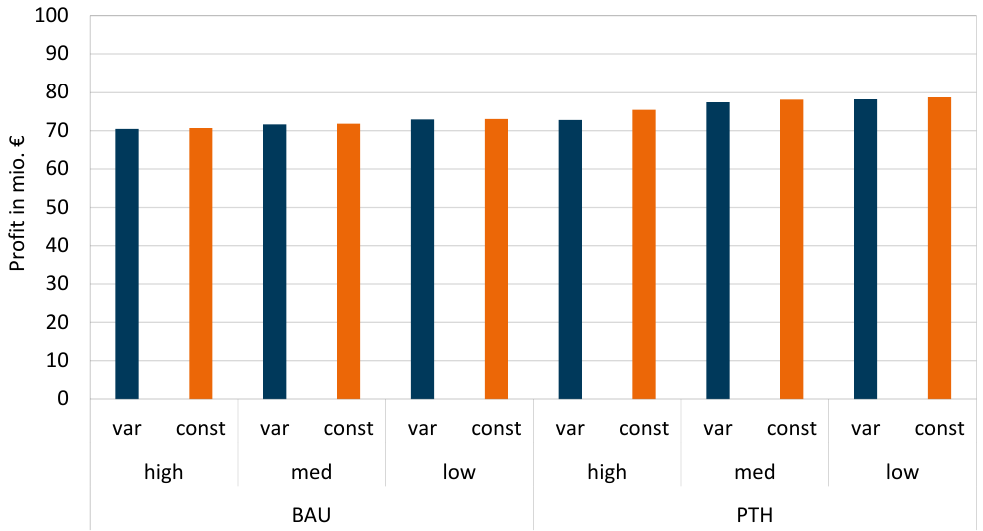
Figure 7. Annual operational profits by scenario, temperature level, and modeling